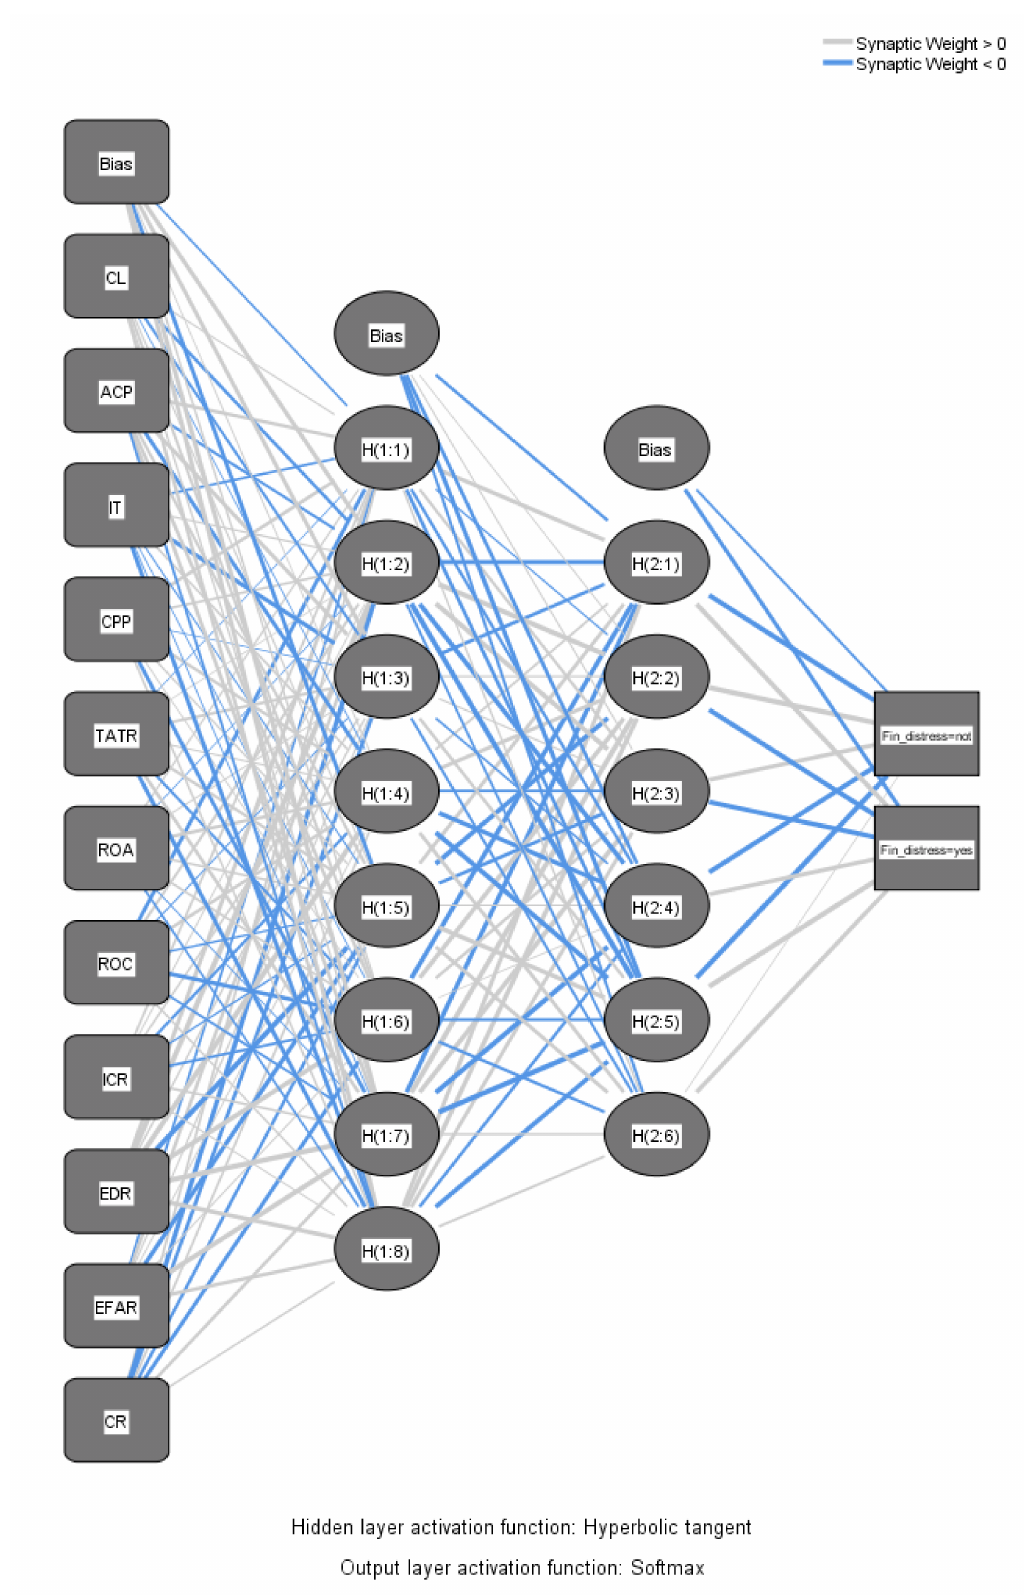
Figure 2. MLP. Source: